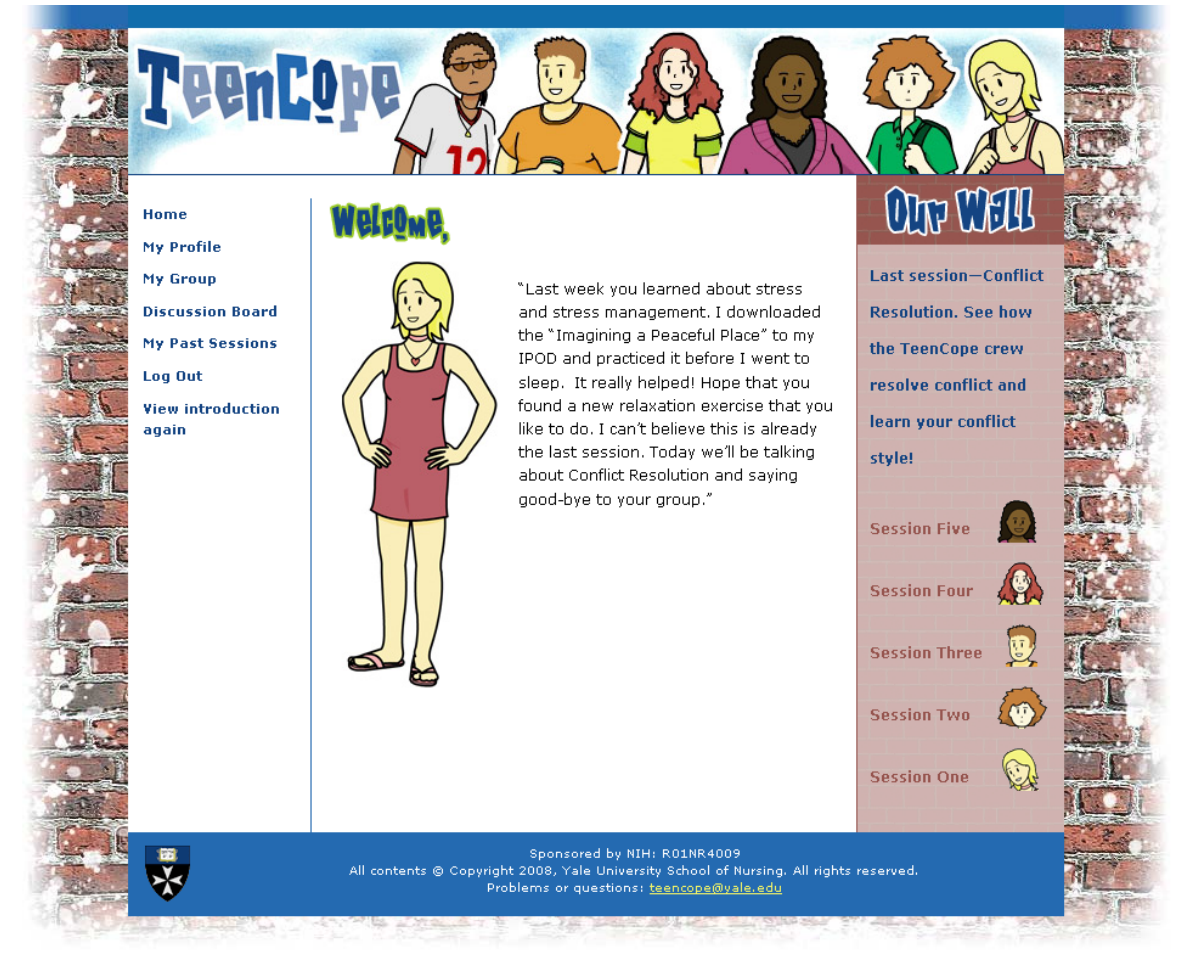
Figure 1. TEENCOPE screenshot displaying home page image, which is updated as teen progresses through the